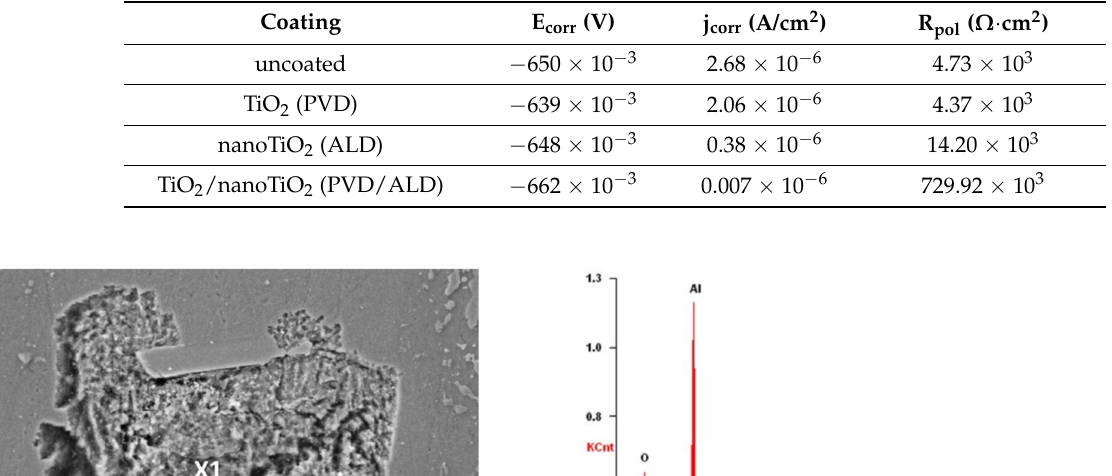
Figure 5. Anodic polarisation curves for an uncoated Al-Si-Cu alloy substrate, as well as coated by the investigated coatings. Table 2. Summary of corrosion parameter values from Tafel analysis of investigated samples.